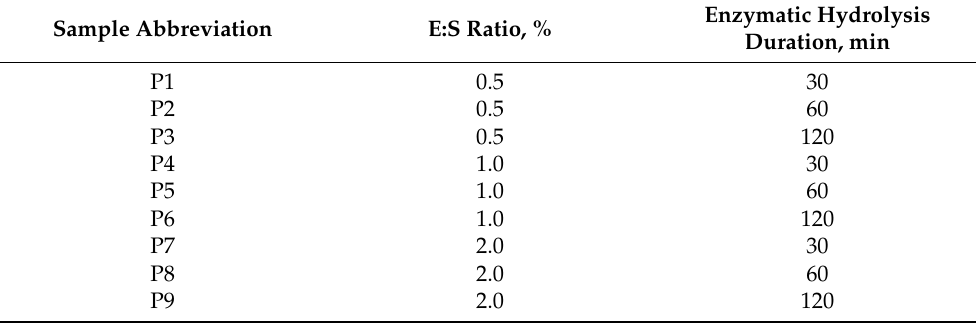
Table 1. Hydrolysates abbreviation and hydrolysis